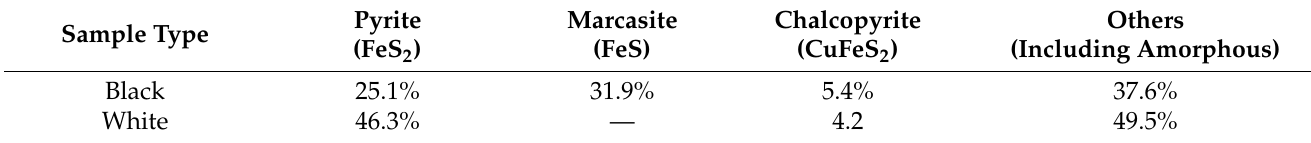
Table 1. Main mineralogical compositions of the SMS samples.